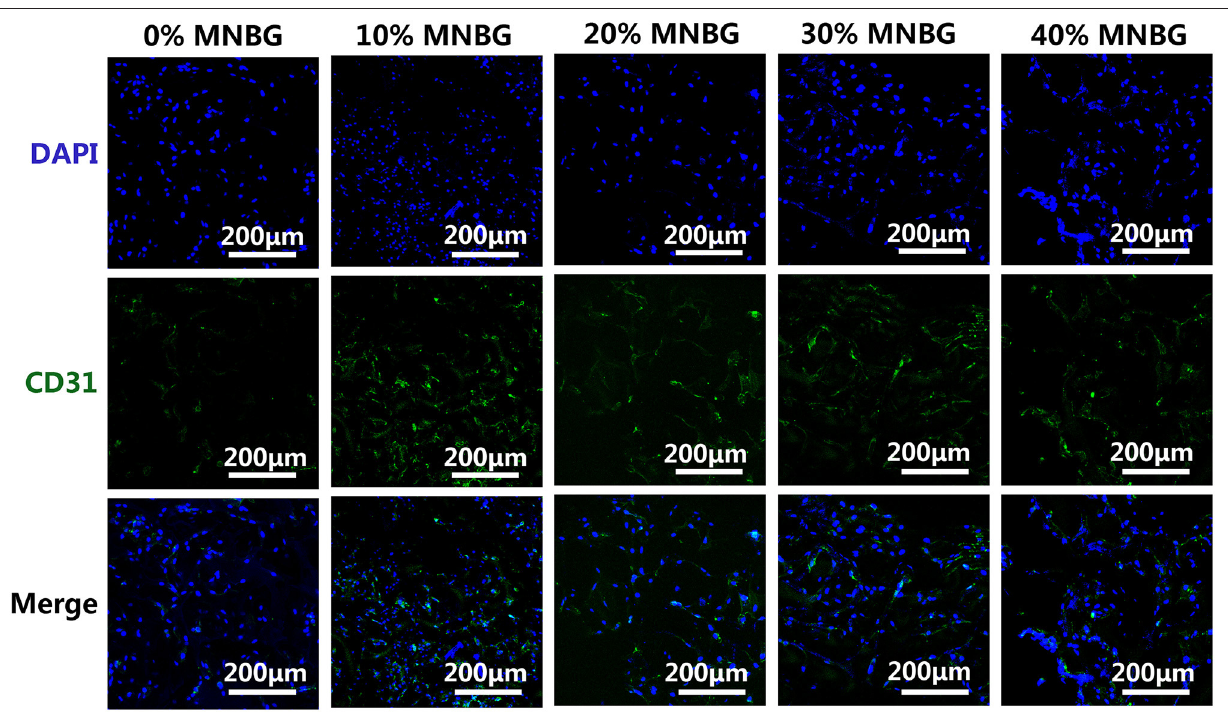
Frontiers in Chemistry |